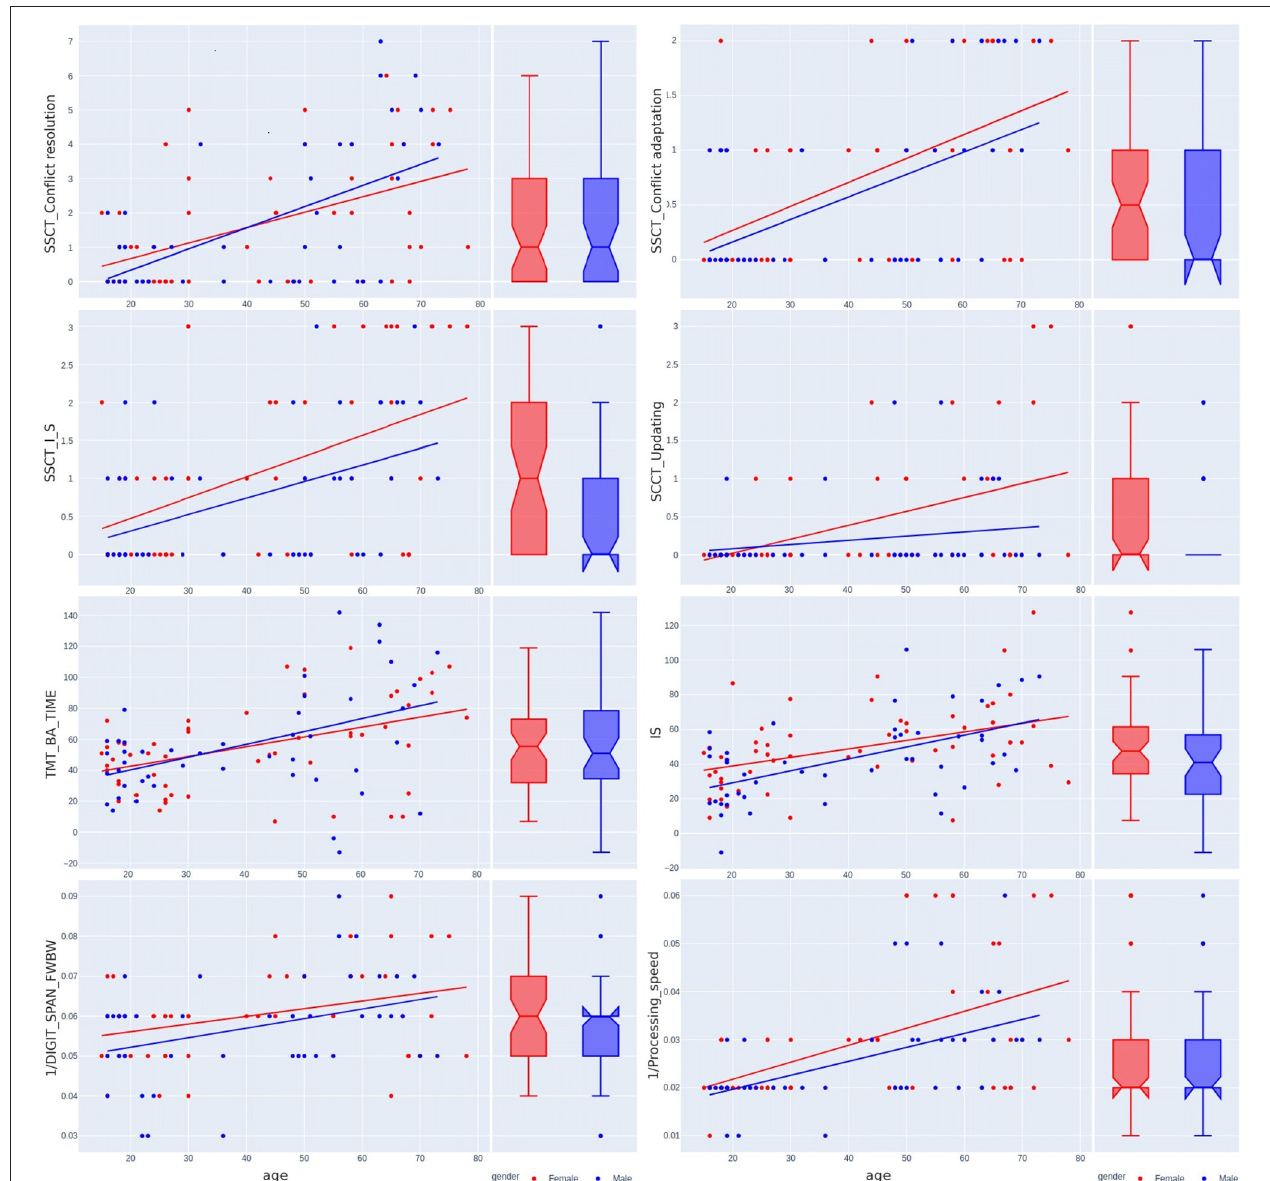
FIGURE 7 | Sex-related differences in the Stroop switching card test, trial making test, Stroop color and word test, digit span forward and backward test, and digit symbol substitution test across the